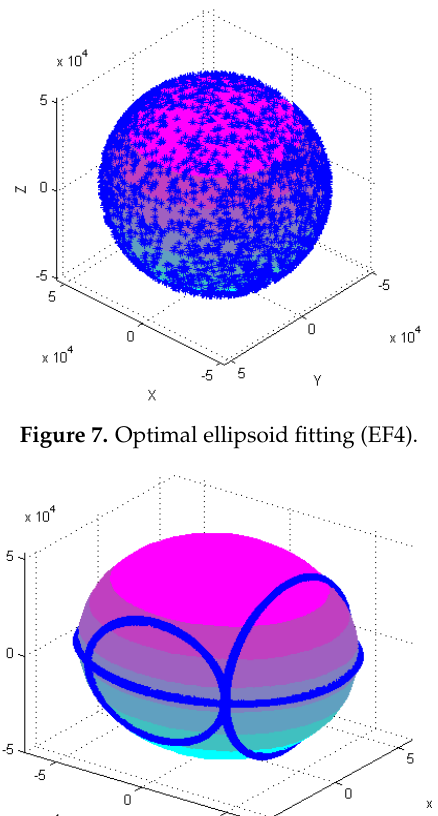
Figure 6. Optimal ellipsoid fitting (EF3) Figure 7. Optimal ellipsoid fitting (EF4). Figure 8. Optimal ellipsoid fitting (EF5).